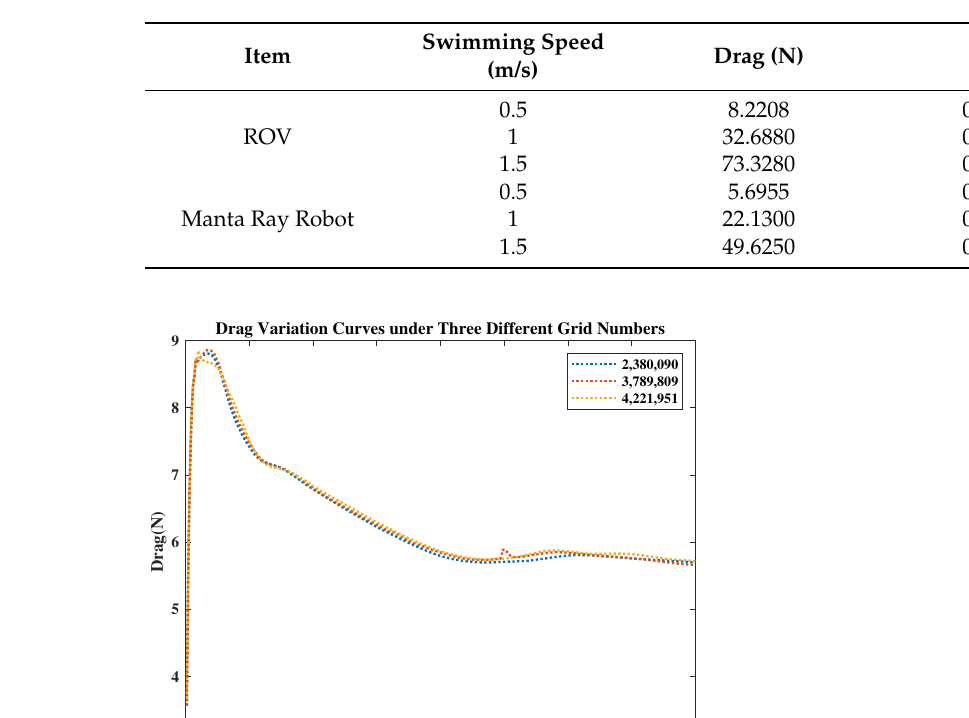
Table 2. The results of the numerical simulation.